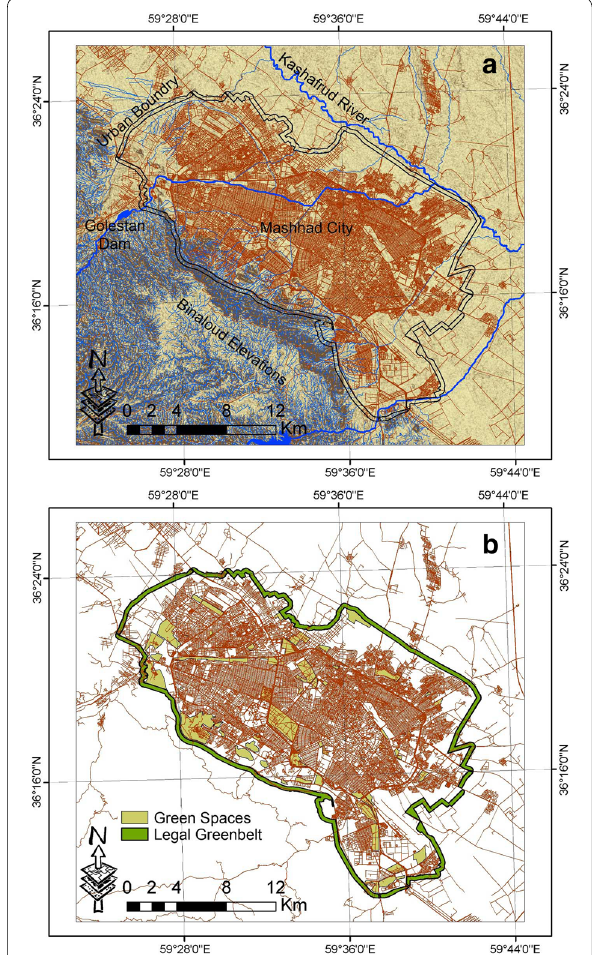
Fig. 1 General position and geographical location of a the study area, and b legal greenbelt